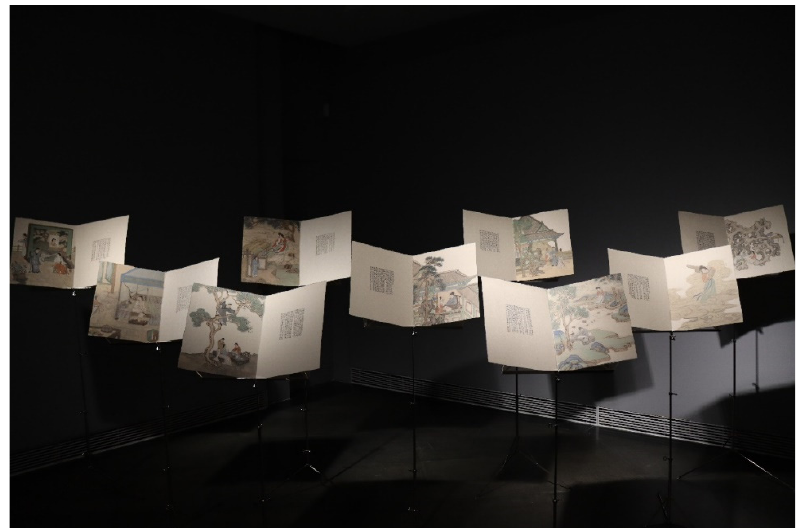
Figure 6. “The One in My Dreams” by Wei Peng, 2019. Ink on paper, painting installation.